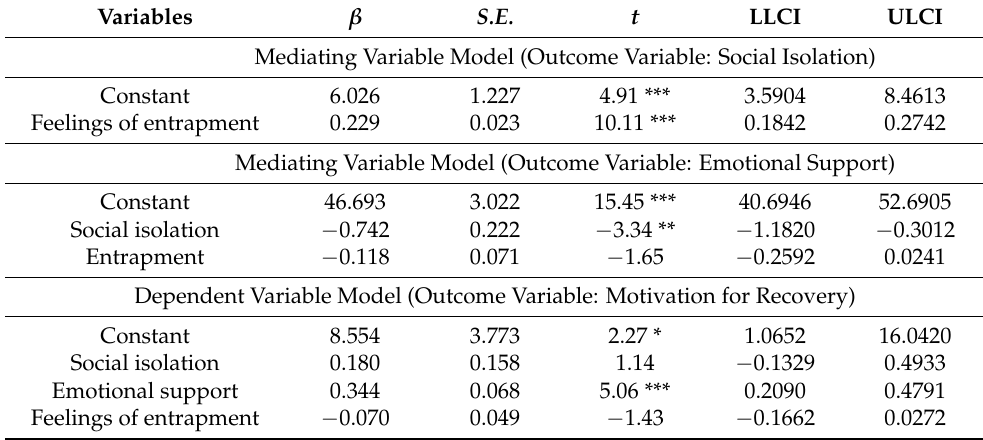
Table 3. Double mediating effect of social isolation and emotional support on feelings of entrapment and motivation for recovery of alcoholic